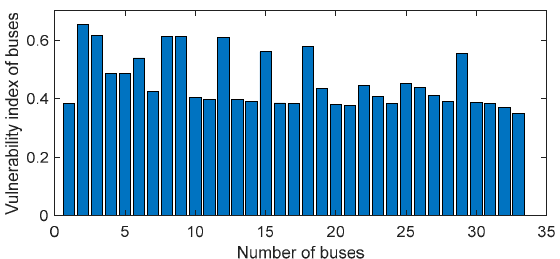
Figure 9. The vulnerability index of the IEEE 33 bus system.